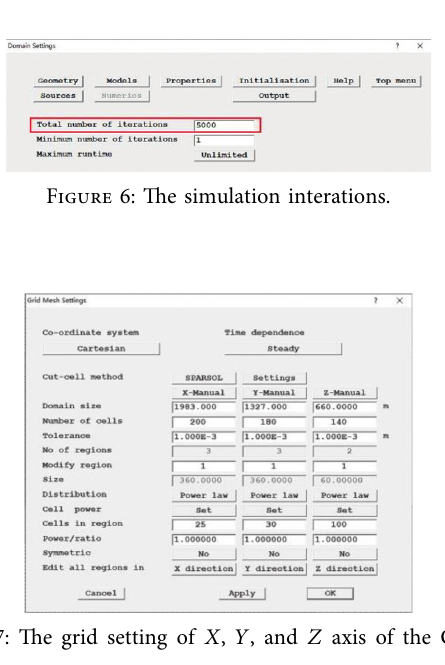
Figure 5: The computational domain.